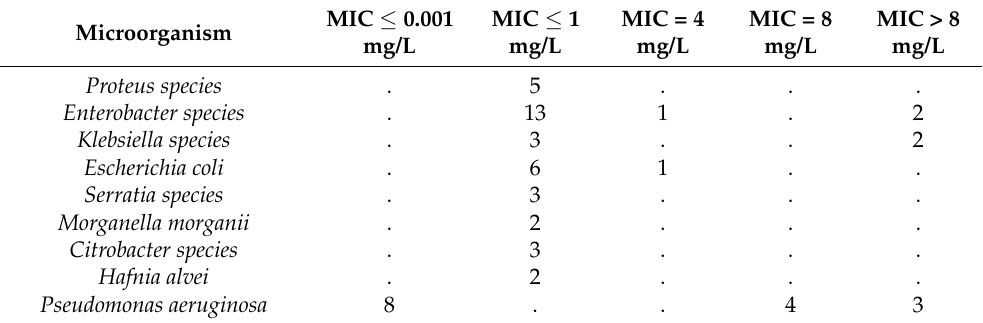
Table 3. Microorganisms isolated in patients with microbiologically proven infections with their cefepime MICs according to EUCAST clinical breakpoint defining susceptibility or resistance. MIC ≤ 0.001 MIC ≤ 1 MIC = 4 MIC = 8 MIC > 8 Microorganism mg/L mg/L mg/L mg/L mg/L Proteus species . 5 . . . Enterobacter species . 13 1 . 2 Klebsiella species . 3 . . 2 Escherichia coli . 6 1 . . Serratia species . 3 . . . Morganella morganii . 2 . . . Citrobacter species . 3 . . . Hafnia alvei . 2 . . . Pseudomonas aeruginosa 8 . . 4 3